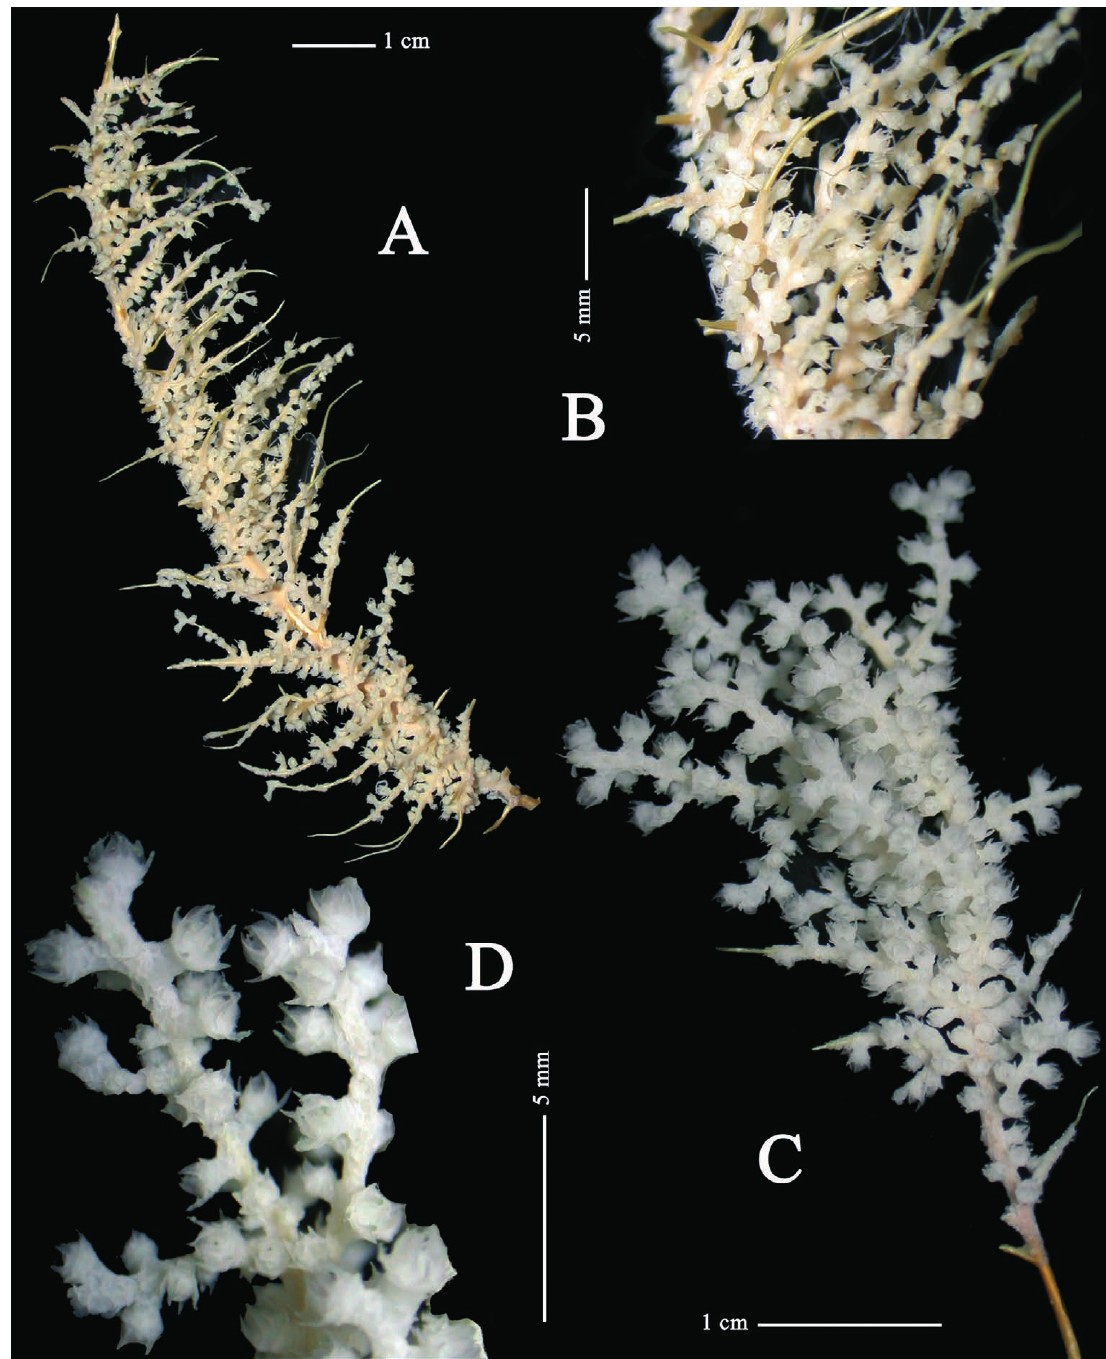
Fig . 8. – Thouarella undulata n. sp., holotype ZiZMH c11742: a, whole colony; b, detail of a branchlet. Thouarella andeep n. sp. , holotype ZiZMH c11744: c, whole colony; d, detail of a Marginal scales (Fig. 10c), eight in number, ar- inner surface tuberculate, covering part of thorn base, ranged in two alternate cycles of four scales. basal part with distal smooth areas. outer surface with smooth of scale obtuse triangle-shaped projecting a high thorn granules covering all scales. Free margin finely ser- nearly round in section, 0.69-1.47 x 0.53-0.70 mm (in- rated, proximal margin with digitate processes. body scales (Fig. 10d), fan-shaped, with ten- cluding thorn), thorn 64-80% of total sclerite length. thorn with numerous longitudinal ridges on all sides. dency to oval shape, 0.34-0.61 mm in diameter. Sci. MaR., 74(1), March 2010, 131-146. iSSn 0214-8358 doi: 10.3989/scimar.2010.74n1131